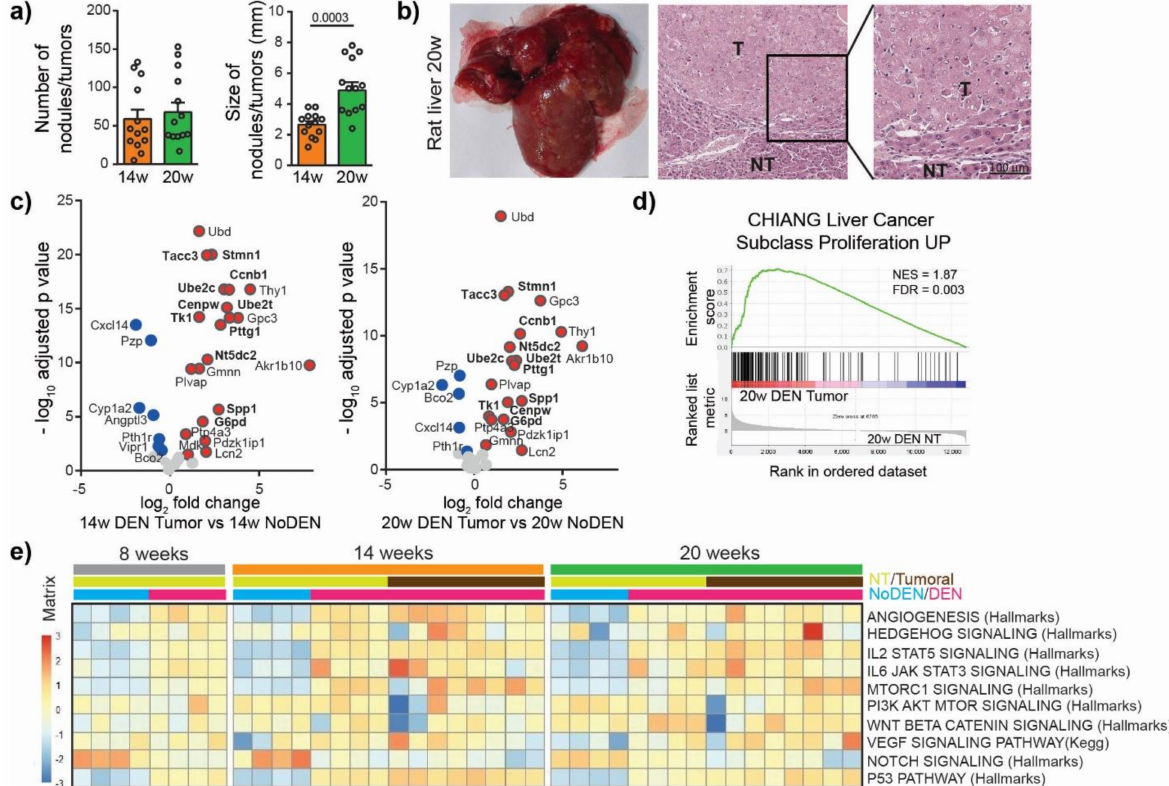
Figure 3. DEN-induced rat model of HCC shows genetic and molecular similarities with human HCC. ( a ) Macroscopic examination of livers with assessment of tumor number at the surface of livers and tumor size (average of diameter of the five largest tumors). Each circle represents an individual animal, mean ± SE, n = 13/group. Comparison of means was performed by unpaired t test. ( b ) Representative picture of rat liver at 20 w and representative images of hematoxylin and eosin (H&E)-stained sections proving HCC, (20 × magnification). T = tumor, NT = Non-tumor tissue. ( c ) Volcano plot displaying differential gene expression in tumors at 14 w (left) and 20 w (right) by RNA-seq. The log-transformed adjusted p -values are plotted on the y-axis and log2 fold change values on the x -axis, with the threshold for a relative expression fold change ≤ − 0.5 or ≥ 0.5 and adjusted p ≤ 0.05. Significantly over-expressed genes (red circles) and under-expressed genes (blue circles) in DEN-induced tumors based on top 25 over-expressed and top 25 under-expressed genes in human HCC. Only the top 25 over-expressed and top 25 under-expressed genes in human HCC are shown in this volcano plot. Genes whose high expression is associated with unfavorable prognosis in human liver cancer are marked in bold. ( d ) Gene Set Enrichment Analysis (GSEA) of RNA-seq data from 20 w DEN tumor tissue showing the enrichment of genes associated with human liver cancer subclass characterized by increased proliferation. NES = normalized enrichment score; FDR = false discovery rate. w = weeks. ( e ) Heatmap showing the single-sample GSEA scores for gene sets classically associated with the development of human